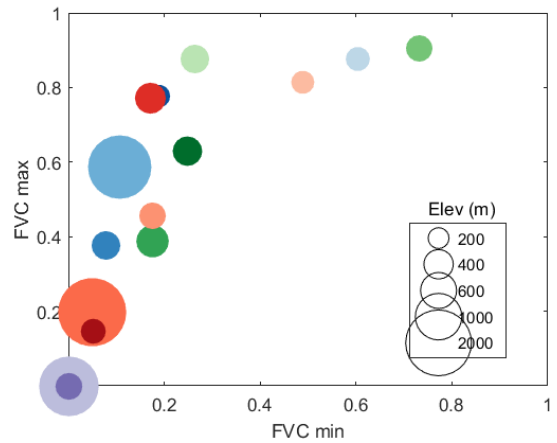
Figure 2. Cluster centroids of the surface classification in terms of their annual maximum and minimum fraction of vegetation cover (FVC). The size of the circles represents the clusters mean elevation (see legend) and colors correspond to the color bar of Figure 1.